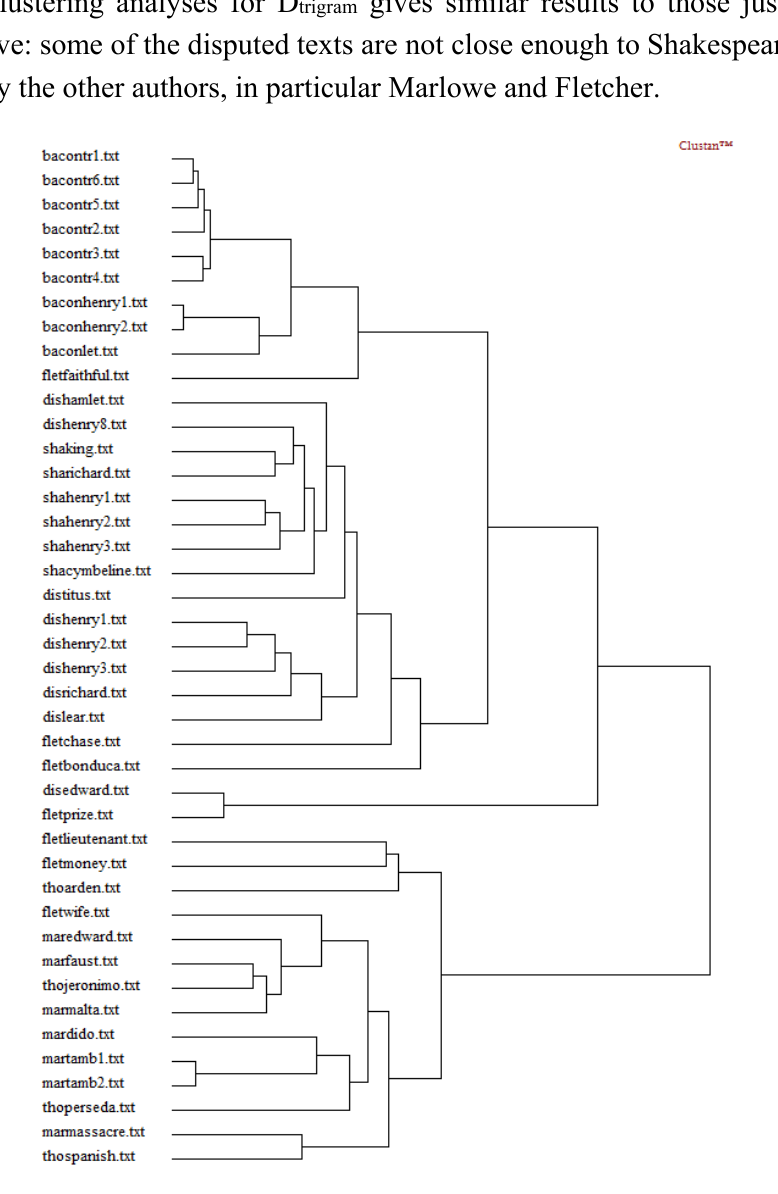
Figure 21. The hierarchical cluster analysis of D trigram using Product-Moment correlation and Mean